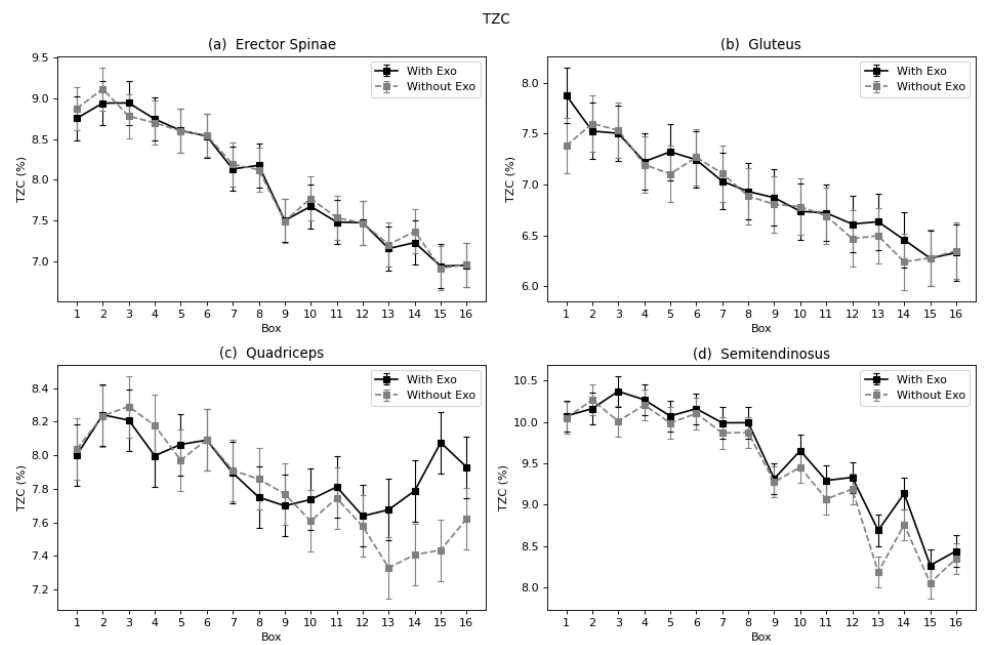
Figure 6. Marginal mean curves with the standard error bars of TZC parameter throughout the 16 boxes for all four muscles: ( a ) Erector Spinae, ( b ) Gluteus, ( c ) Quadriceps, and ( d ) Semitendinosus.